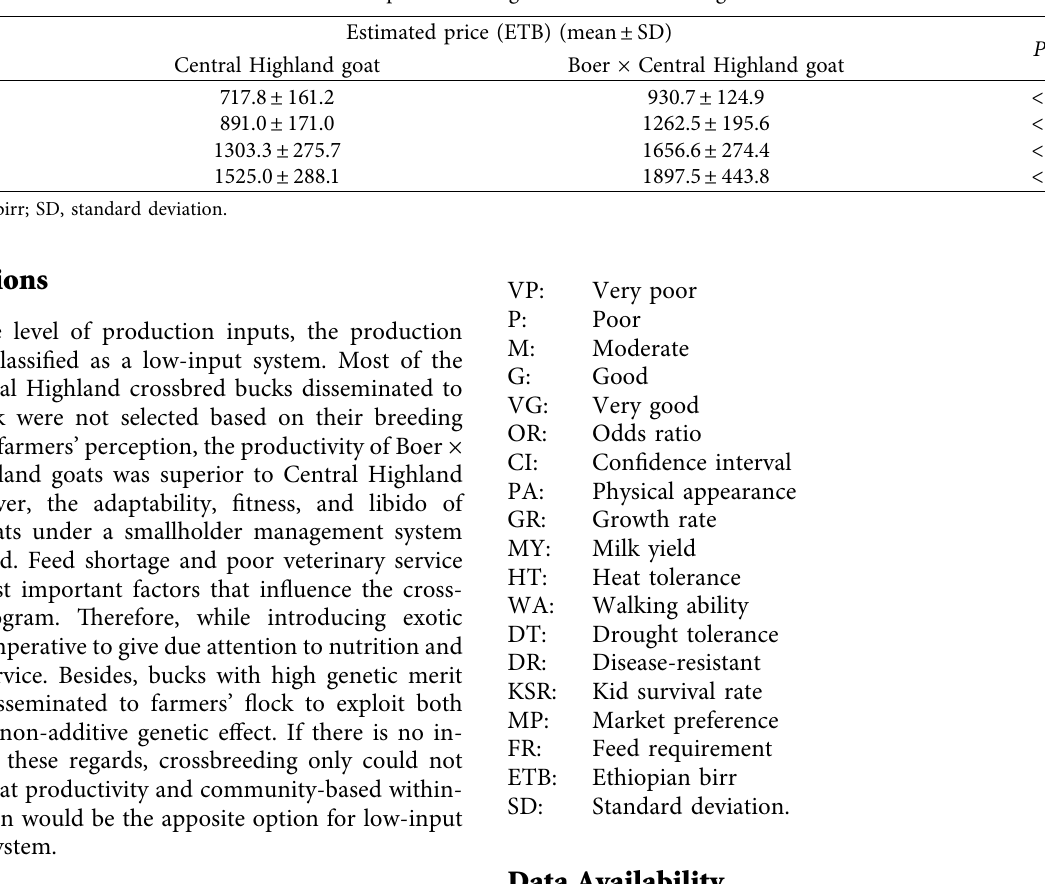
Table 7: Estimated price for indigenous and crossbred